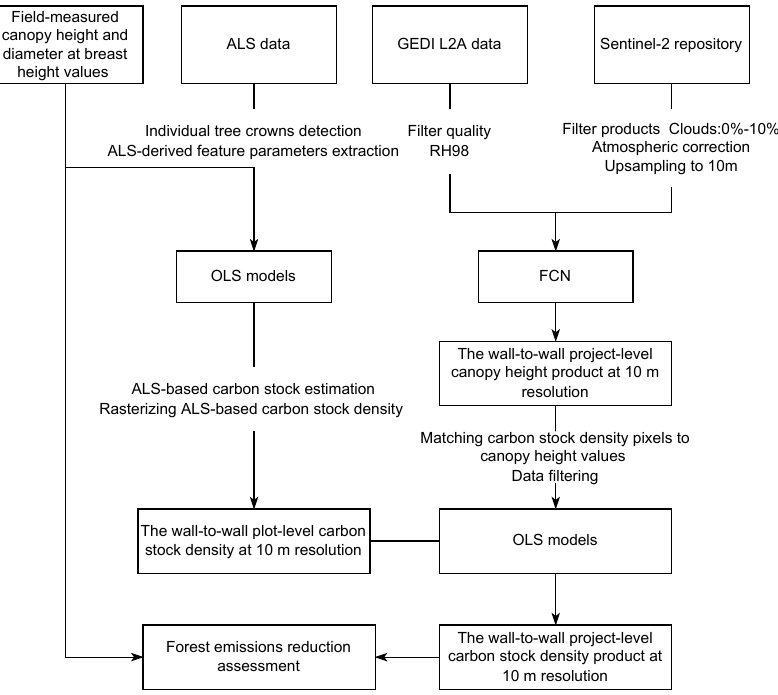
Figure 1. Forest emissions reduction assessment